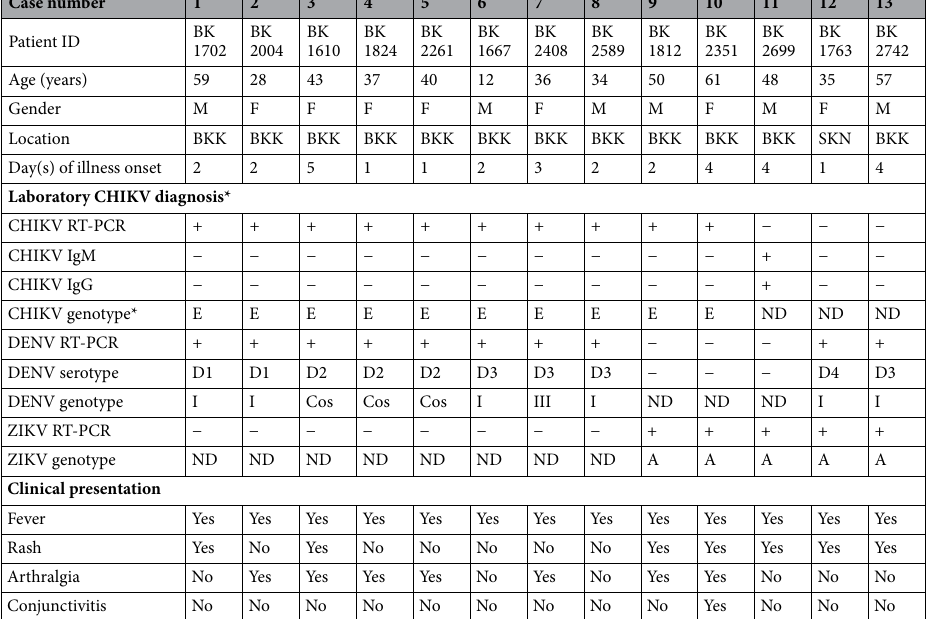
Table 2. Demographic data, laboratory diagnostic test results, and clinical presentation of CHIKV/ZIKV/ DENV co-infected cases. M Male, F Female, BKK Bangkok, SKN Samut Sakhon, E East/Central/South African genotype, D1 Dengue virus serotype 1, D2 Dengue virus serotype 2, D3 Dengue virus serotype 3, D4 Dengue virus serotype 4, I Genotype I, Cos Cosmopolitan genotype, III Genotype III, A Asian genotype, + Positive result, − Negative result, ND Not done. *Results from our previous cohort chikungunya study. Case numbers 1–8 involved CHIKV/DENV co-infection, Case numbers 9–11 involved CHIKV/ZIKV co-infection, and Case numbers 12–13 involved DENV/ZIKV co-infection.